Question: Write a single sentence explaining what this figure depicts.
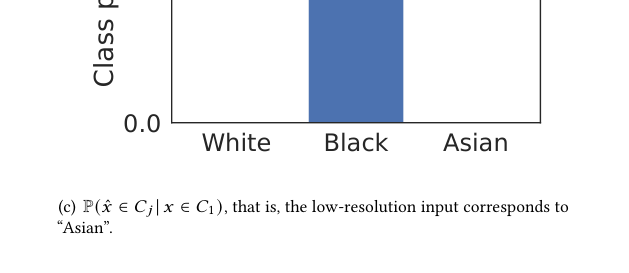
Answer: Given a low-resolution input (“White”, “Black”, or “Asian”), we assume that the class distributions of the re- constructions are given by the following probability mass functions.